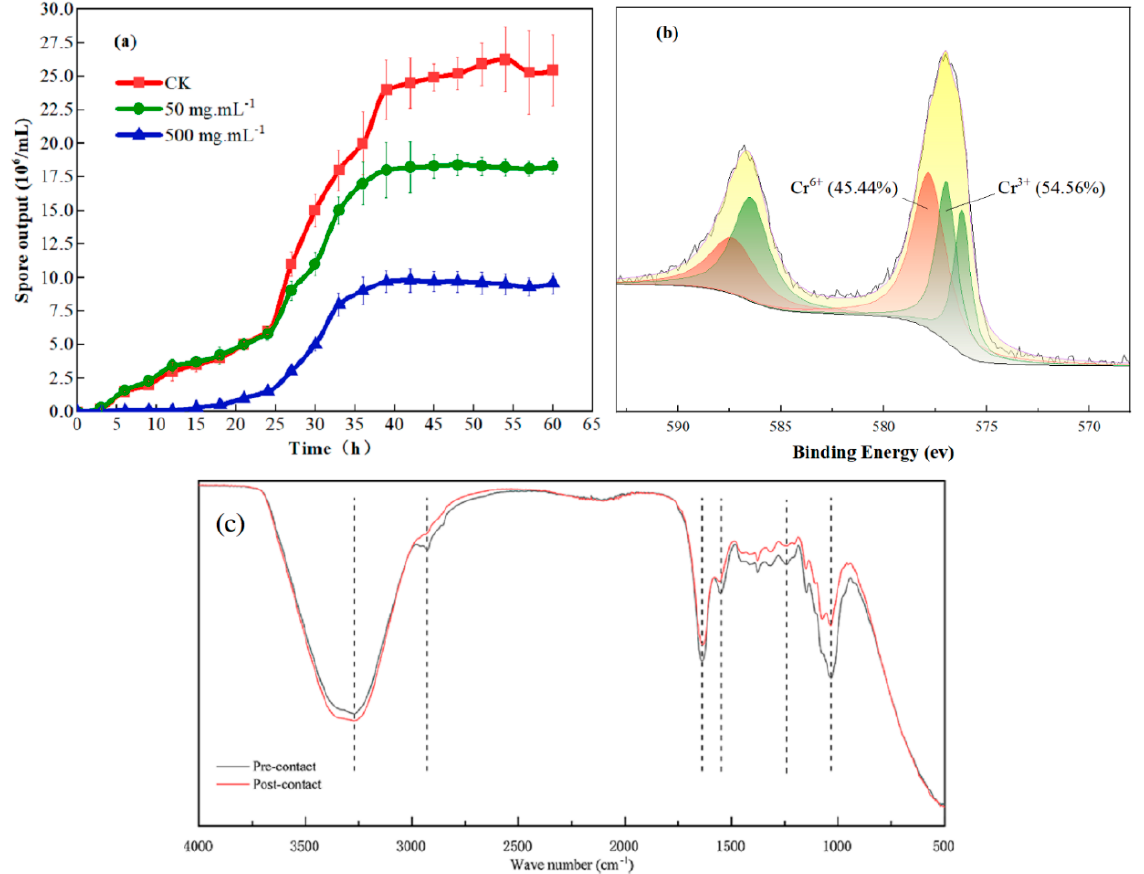
Figure 2. ( a ) Sporulation curves of Aspergillus niger strain A1 in chromium solution. CK—control. ( b ) X-ray photoelectron spectroscopy patterns of A. niger after 24 h of exposure to Cr 6+ . ( c ) Fourier transform infrared spectroscopy analysis of A. niger pre-contact or post-contact with Cr 6+ .